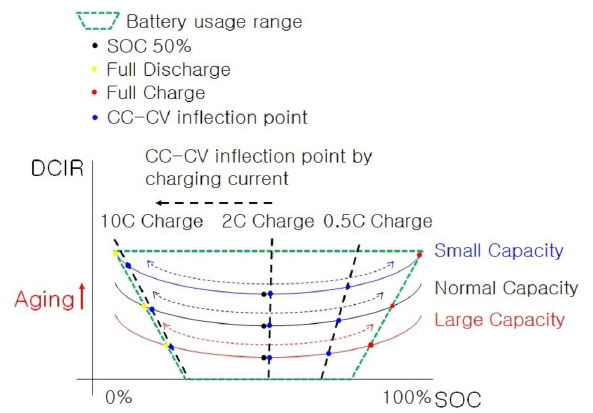
Figure 3. Range of use for series-connected batteries with different capacities.